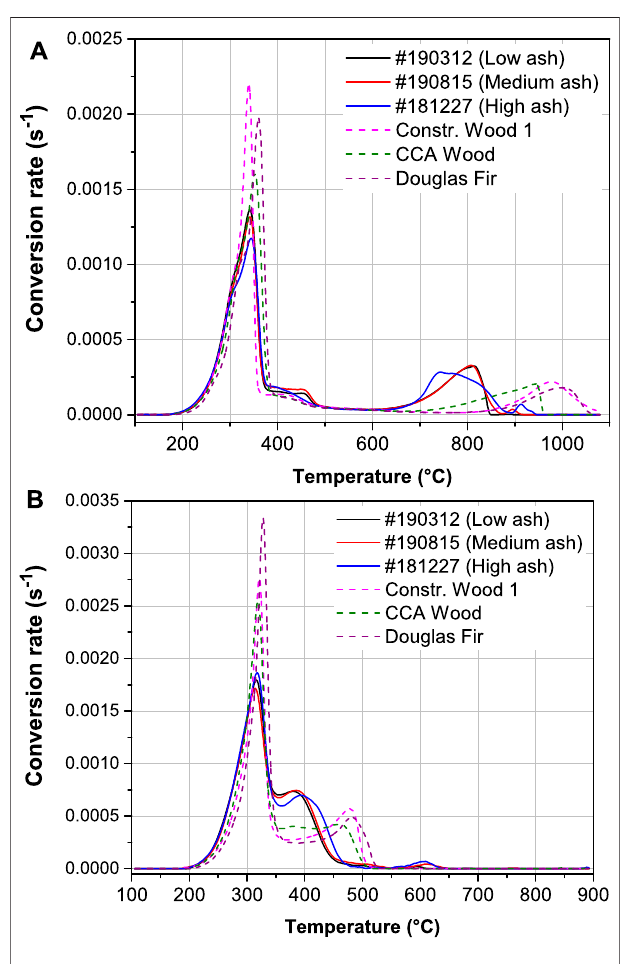
FIGURE 9 | Reactivity of CCDWDF materials in (A) reducing and (B) oxidizing atmospheres.